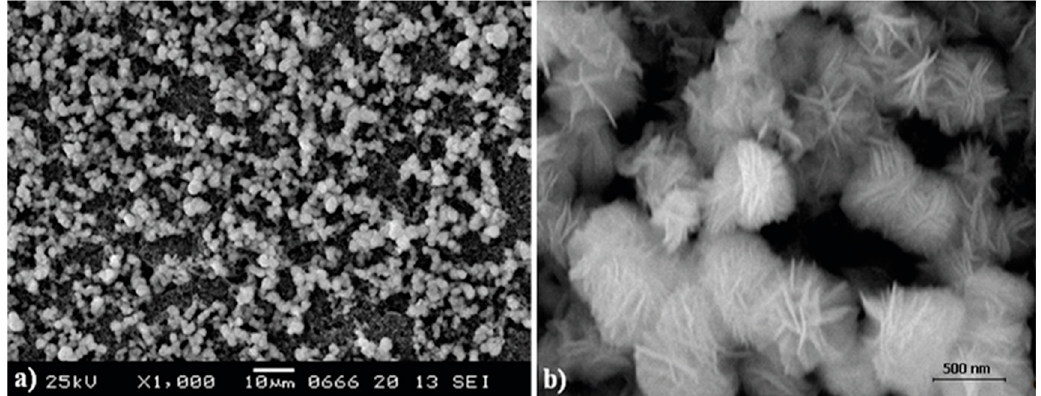
Figure 3. ( a ) SEM image of the sulfur particles produced by means colloidal sulfur (CS) solution; ( b ) particles at 10,000× magnification.